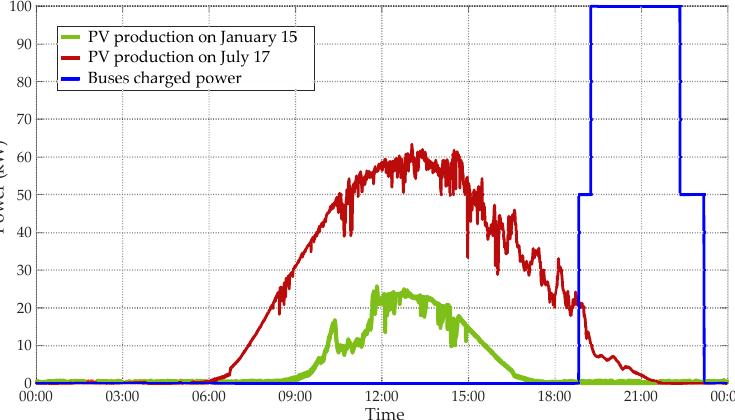
Figure 9. Total charging power and PV production over time—scenario